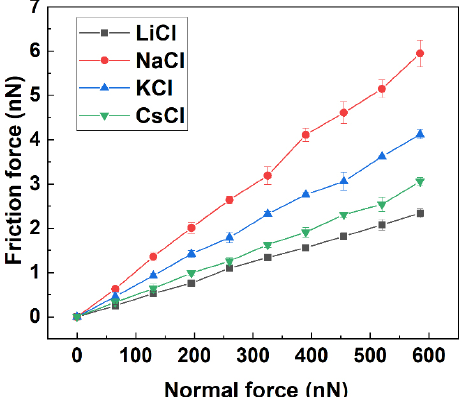
Fig. 5 Friction forces between PVPA-modified Ti6Al4V and PS ball in different salt solutions.